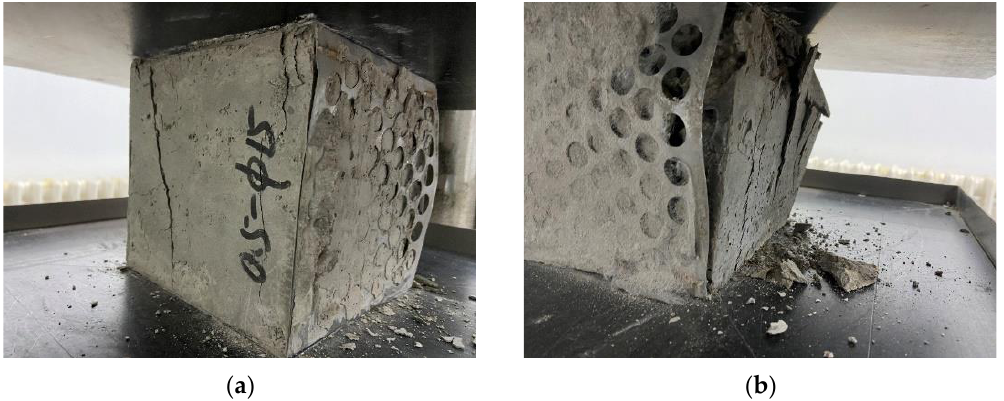
Figure 8. Block damage: ( a ) the surface of the specimen is penetrated by cracks; ( b ) the specimen is damaged.